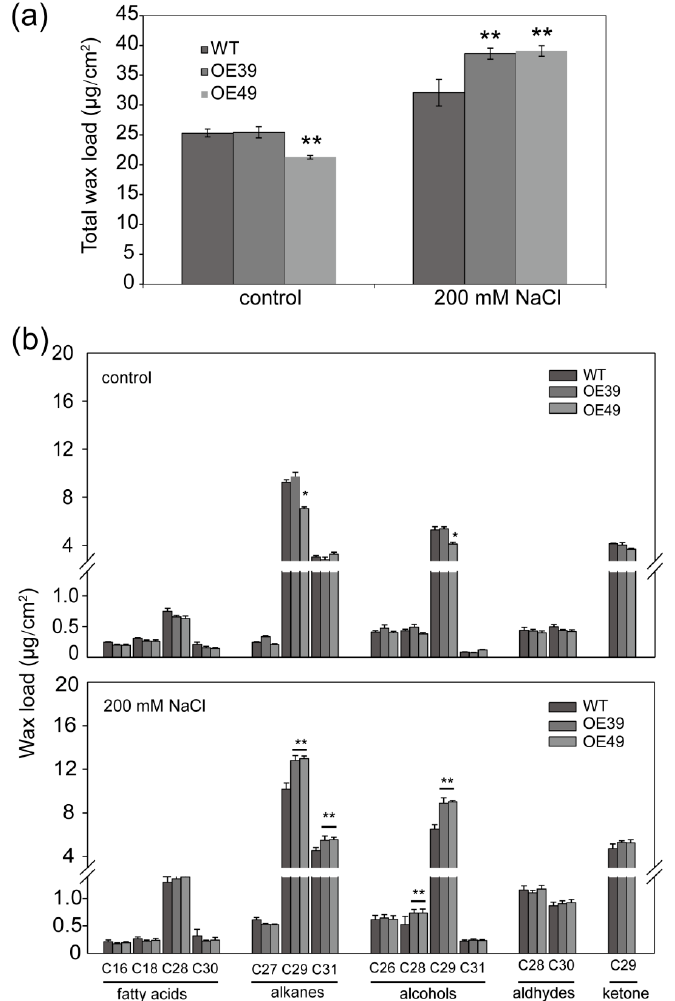
Figure 5. Effect of BnWIN1 on wax content and compositions under salt stress. ( a ) Total wax content in leaves of BnWIN1 -OE and WT plants under control and salt stress conditions. Values are means ± SD ( n = 5). ( b ) Wax compositions in leaves of BnWIN1 -OE and WT plants under control and salt stress conditions. Values are means ± SD ( n = 5). Forty-day-old plants grown in soil in pots were treated without (control) or with 200 mM NaCl for 30 days. Epicuticular waxes were extracted from leaf surfaces and quantified by GC-MS analysis. * and ** denote significance at p < 0.05 and p < 0.01, respectively, compared with WT plants based on Student’s t